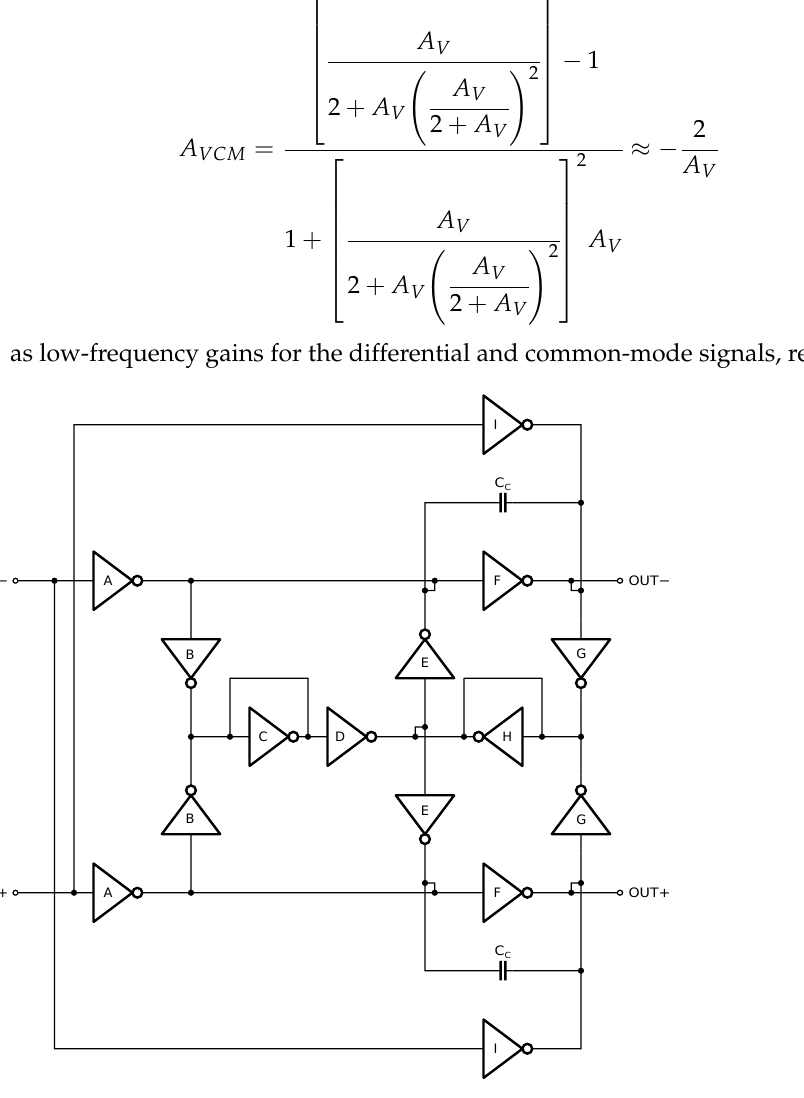
Figure 14. Manfredini/Vieru (M/V) hybrid OTA circuit